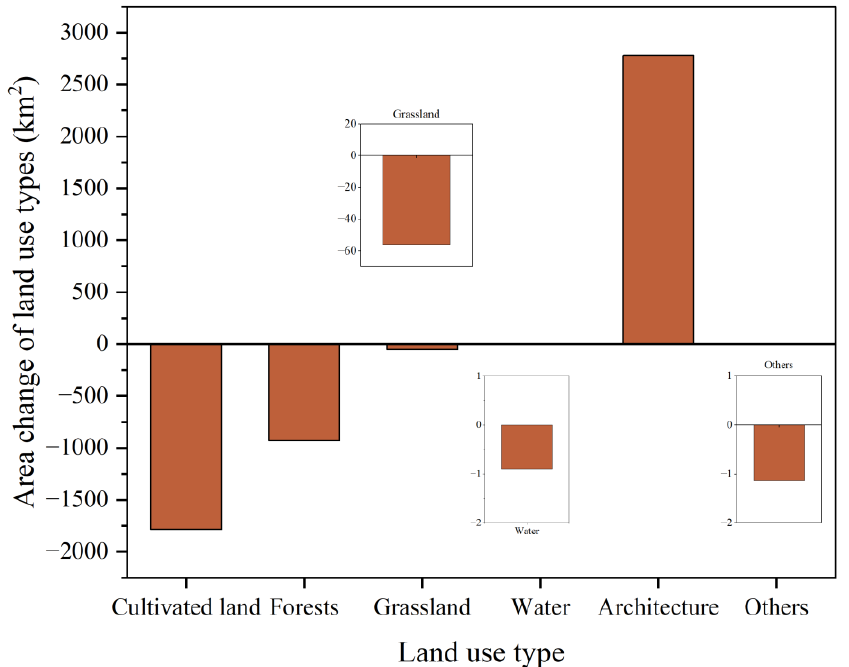
Figure 11. Area changes in land use types in the economic priority scenario from 2020 to